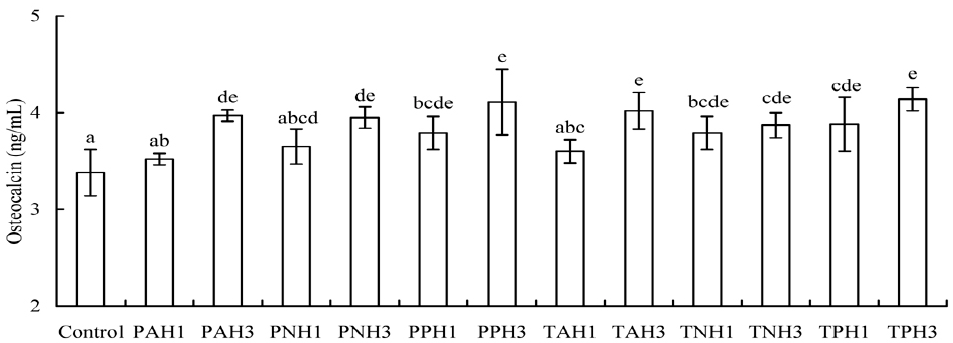
Figure 5. Osteocalcin levels of the osteoblasts exposed to 12 gelatin hydrolysates for 21 days. Different letters above the columns indicate that one-way ANOVA of the means differs significantly ( p < 0.05).